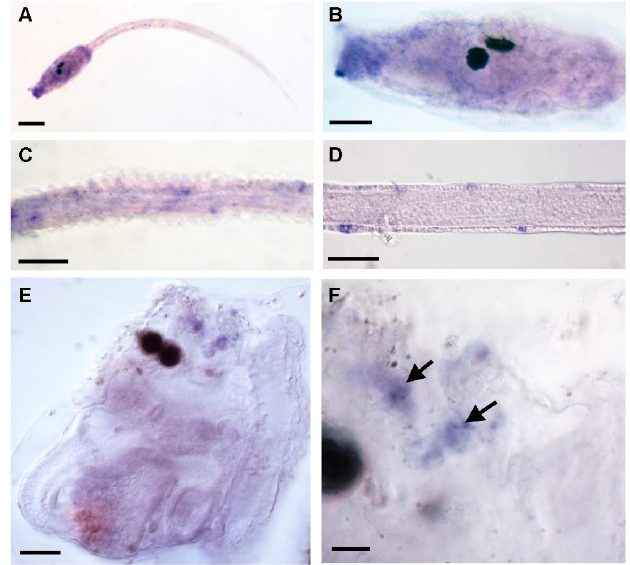
Figure 2. Whole mount in situ hybridization with pri-miR-9 ( A – C ) and anti-miR-9 locked nucleic acid -LNA probe ( D – F ) in larvae and juveniles of Ciona intestinalis . ( A ) Swimming larva. ( B ) Trunk of a larva. ( C , D ) Details of the tail of a swimming larva. ( E ) Whole mount of 5-day-old juvenile. ( F ) Details of the oral siphon region of a juvenile. Arrows indicate positive cells. Scale bar = 50 µ m ( A ), 25 µ m ( B ), 40 µ m ( C , D ), 25 µ m ( E ), 60 µ m ( F